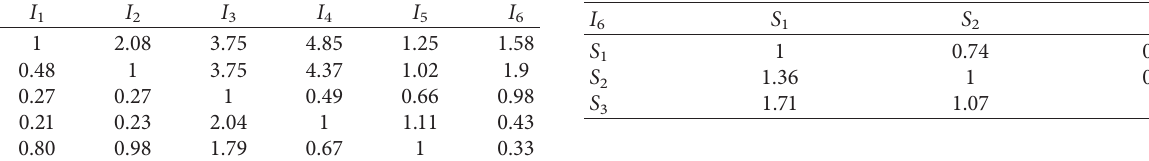
Table 10: Judgment matrix of the strategic layer relative to I